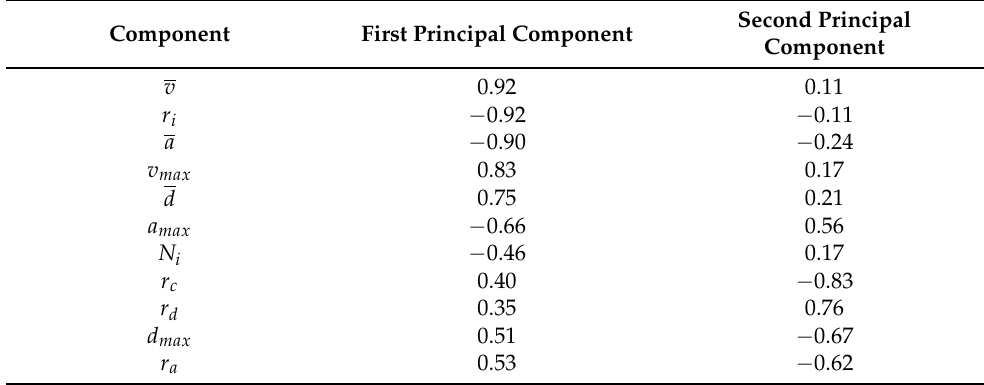
Table 4. The component matrixl